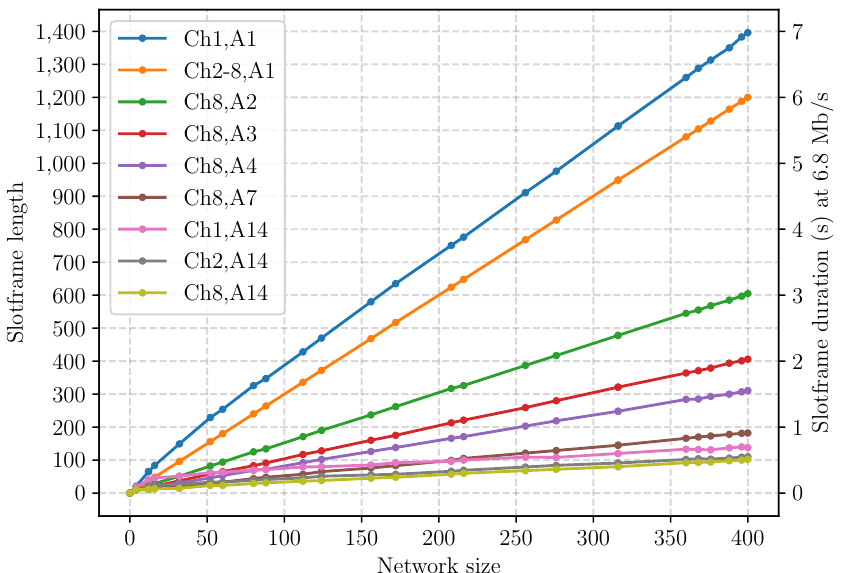
Figure 29. Slotframe length as a function of network size (in cells) in different aggregation scenarios. Each scenario is named Ch m ,A n with m the number of channels and n the amount of aggregation. Each curve corresponds to a different scenario. Each one is named as Ch m ,A n where m is the number of channels and n corresponds to n agg . The baseline curves, entitled Ch1,A1 and Ch2-8,A1 , report the behavior without aggregation ( n agg = 1) with, respectively, a single channel and more than one channel. Recall from Figure 23 that, in the latter case, a number of channels 2 produce a slotframe of maximum length (1200). When we ≥ enable aggregation ( n agg > 1), we allow the maximum of 8 channels to be used. We observe that using an aggregation n agg of 2, 3 or 4 almost reduces the slotframe length by a factor n agg , causing the positioning interval to go down from 6.0 s to 3.025 s, 2.03 s and 1.56 s, respectively, for the largest network. The marginal gain of more aggressive aggregation levels is lower. With the highest value, n agg = 14, and in the largest network, the slotframe duration is reduced to 101 timeslots (0.51 s), a factor of 11.76 compared to without aggregation. A reduction factor of 14 is not reached, mainly because the ranging exchanges cannot be aggregated. The number of transmissions was reduced from 9210 to